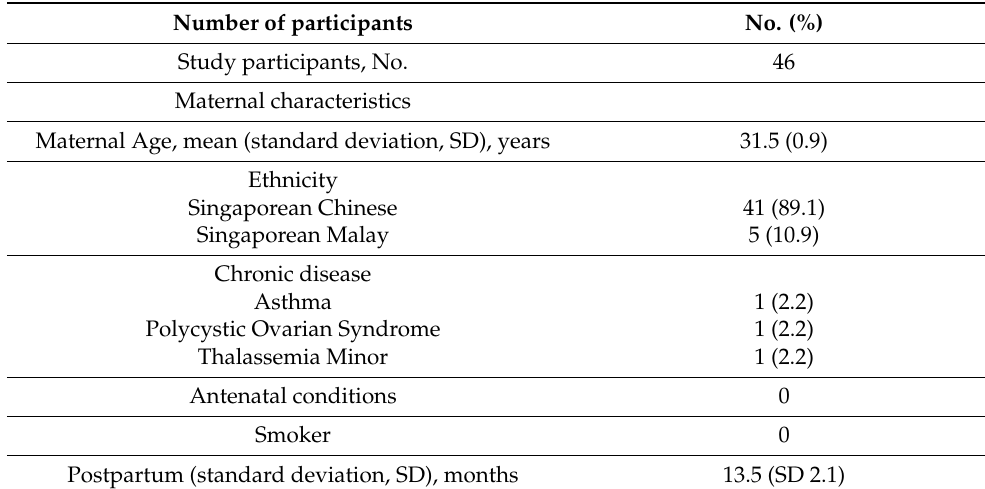
Table 1. Characteristic of lactating women. Number of participants No. (%) Study participants, No. 46 Maternal characteristics Maternal Age, mean (standard deviation, SD), years 31.5 (0.9) Ethnicity Singaporean Chinese Chronic disease Asthma 1 (2.2) Polycystic Ovarian